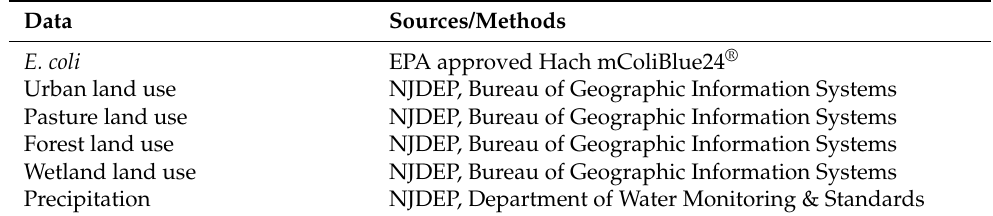
Figure 1. Sampling locations and adjacent land use types in the Musconetcong River watershed in this study. Sampling locations are denoted by yellow dots. The gray area on the map inlet indicates the New York–New Jersey–Pennsylvania metropolitan area (Source: United State Census Bureau). Table 1. Analytical methods and data sources used in this study.